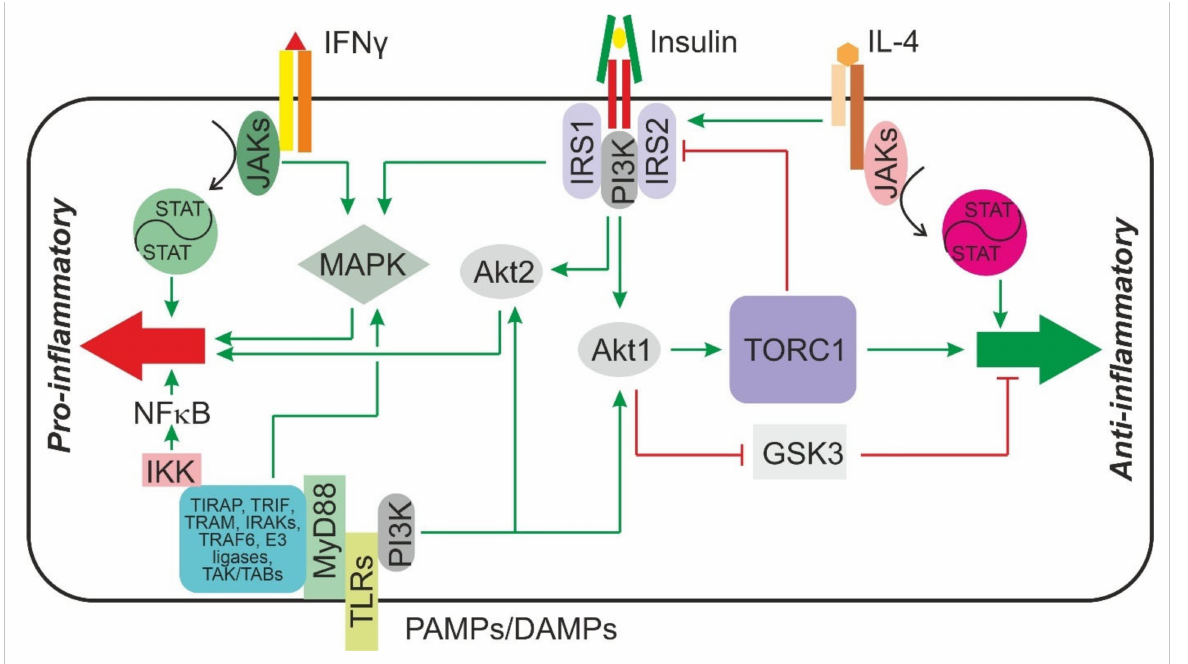
Figure 1. Crosstalk between insulin receptor, toll-like receptors (TLRs), interleukin-4 (IL-4) and interferon γ (INF γ ) signaling in macrophages . The activated insulin receptor tyrosine kinase serves as docking site for insulin receptor substrates (IRS) and downstream signaling components such mitogen-activated kinases (MAPK), phosphoinositide-3-kinases (PI3K) and protein kinase B (PKB)/Akt kinases that modulate the activity of TORC1 and GSK3. The insulin receptor